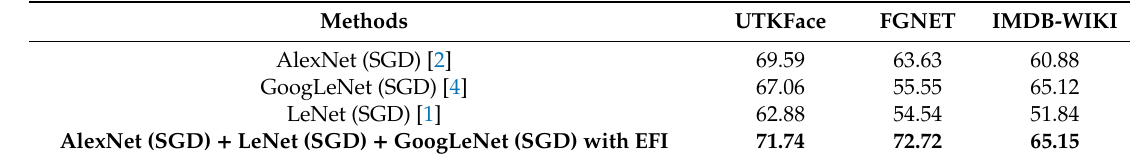
Table 14. Age classification results in three databases.